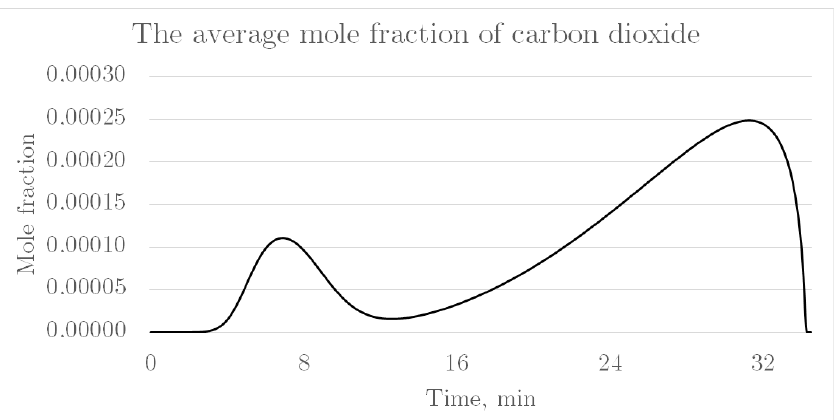
Figure 10. Dynamics of the average molar fraction of carbon dioxide in the reaction mixture in the pores of the catalyst